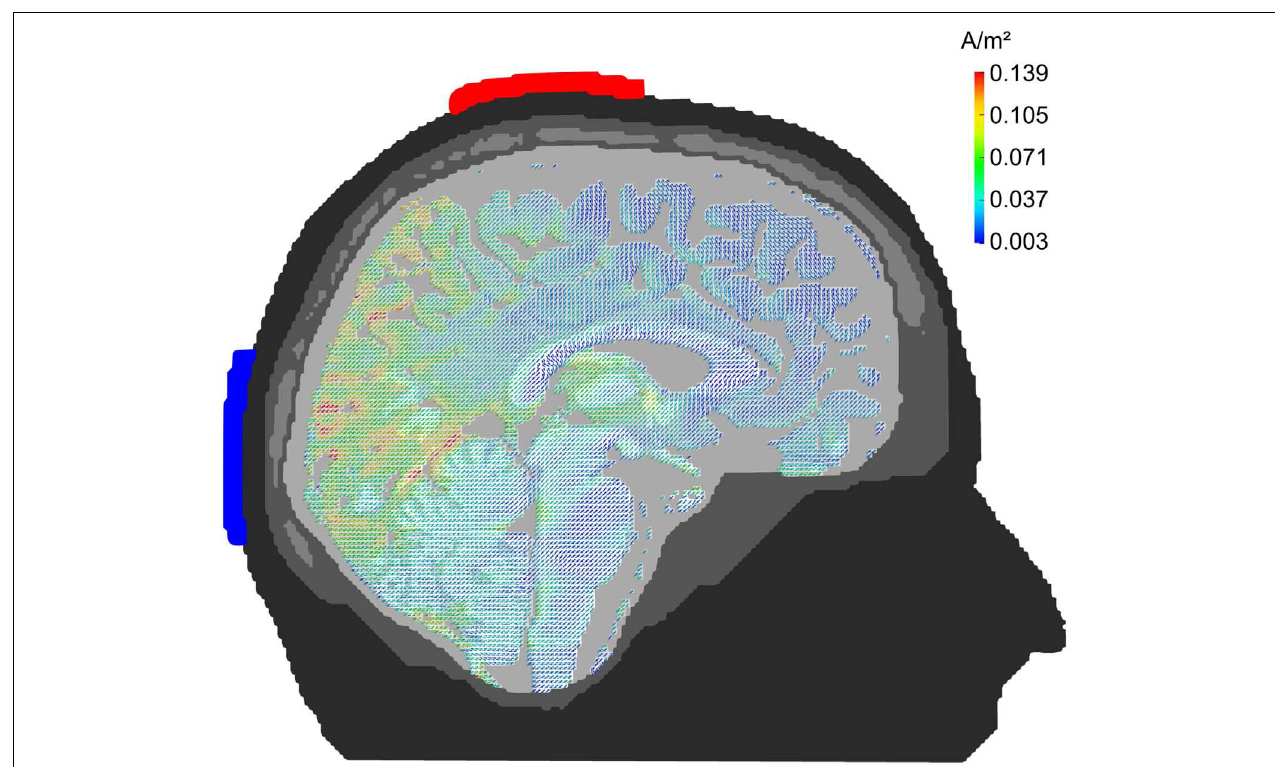
FIGURE 4 | Midline configuration Cz/Oz: sagittal view. Stimulation electrodes are centered around electrode positions Cz and Oz.The pattern of current densities shows a clear maximum in posterior brain areas, especially in occipital cortex.